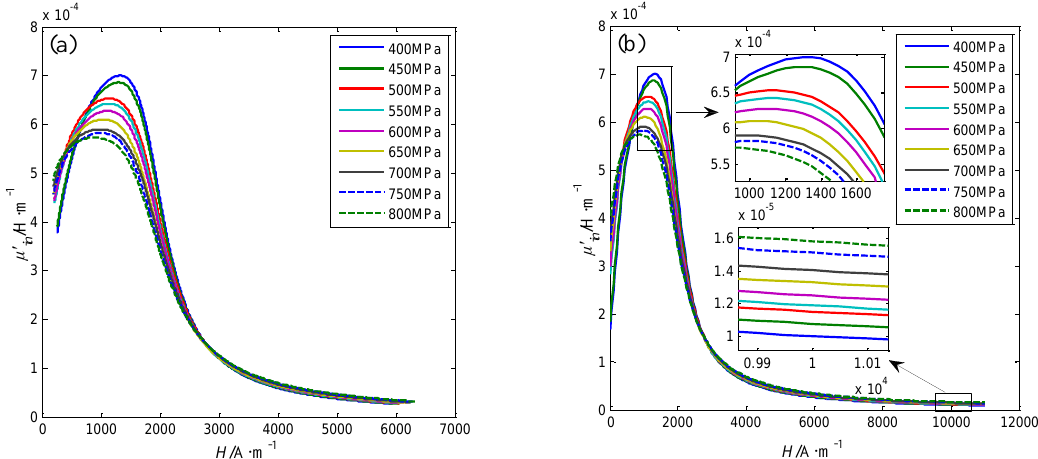
Figure 17. The differential permeability curves before ( a ) and after ( b ) the extrapolation for No.1 Φ7 steel wire under different axial stresses.